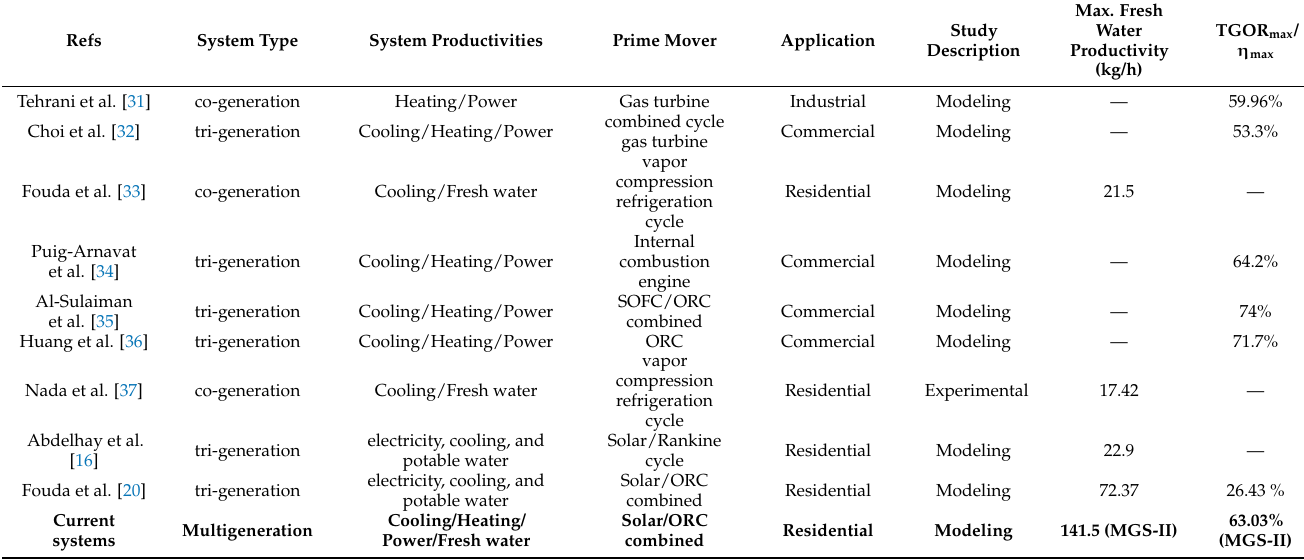
Table 5. Comparison of the current systems with other reported systems.